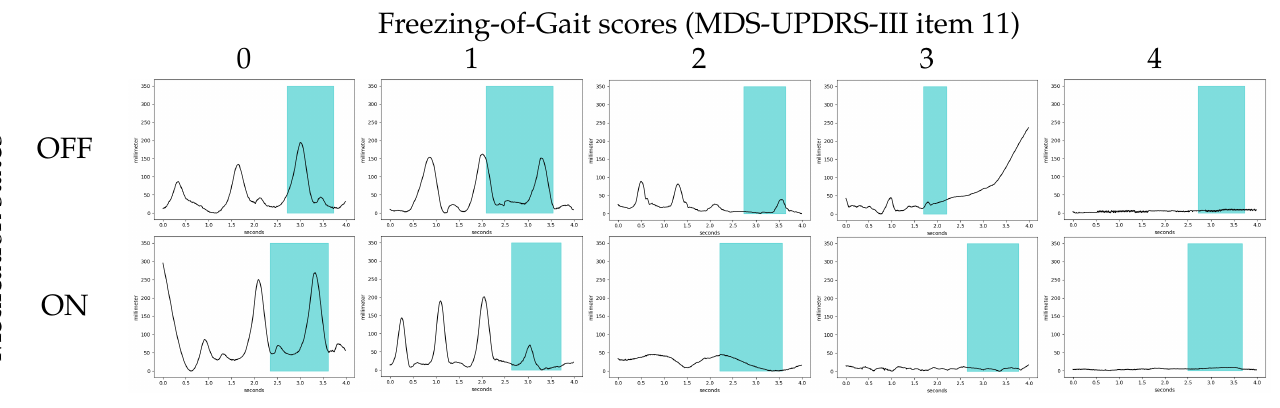
Figure 5. Examples of detected core motion segments of left heel motions from the adaptive trimming model for different medication states and FOG scores. The horizontal and vertical axes of plots are in seconds and millimeters, respectively, with the vertical axis indicating the height of the left heel marker above the laboratory floor. All plots depict four seconds of recorded movement. Core motion segments detected by the adaptive trimming model are depicted in